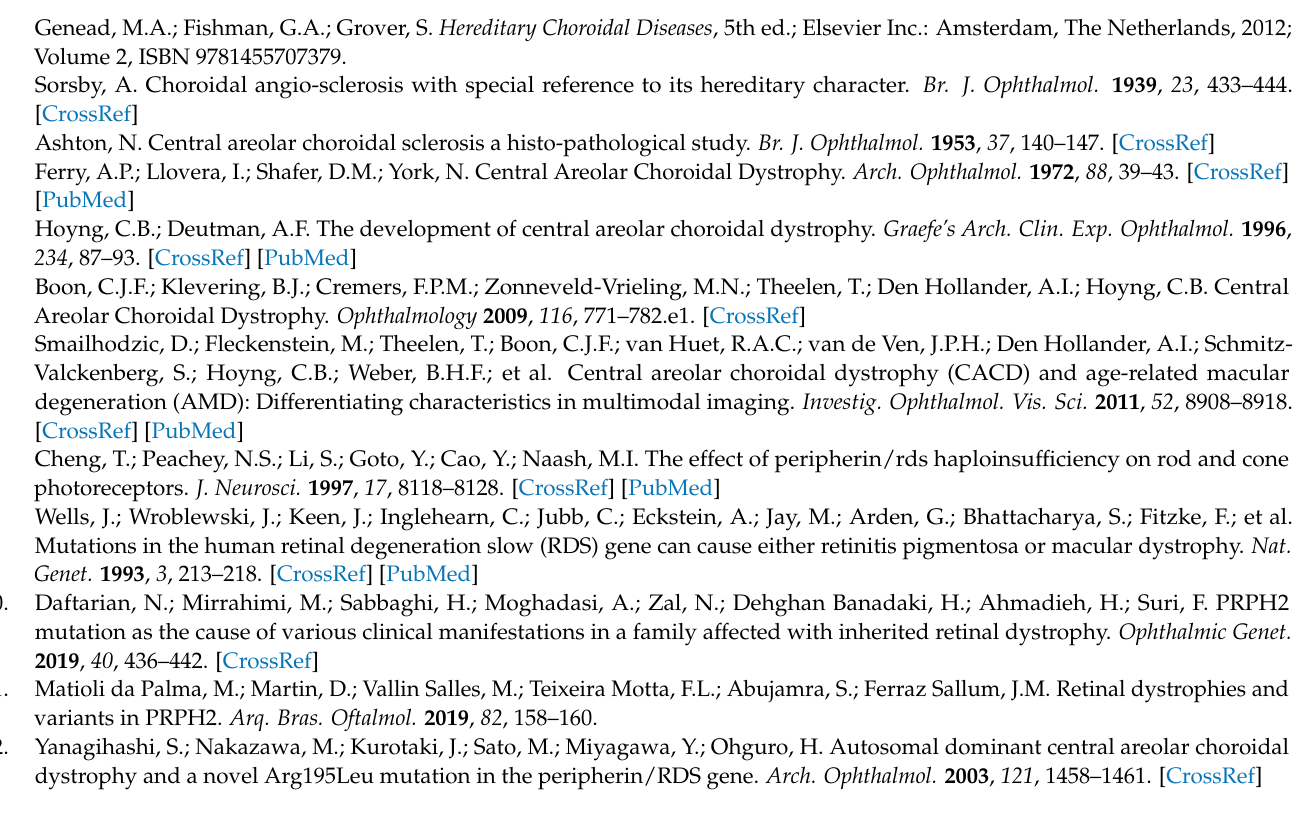
Figure S2: Infrared images of right (upper) and left (down) eyes of control (A,B) and patients with PRPH2 gene mutation (C-I); Figure S3: Three-dimensional reconstruction from a dense OCT scan of some study patients associated to p.Arg195Leu mutation; Figure S4: Volume scan of the GCL thickness map (right) at 1, 2, and 3 circle diameters from the foveola. References [32,42,45,46,49,50] are cited in the Supplementary